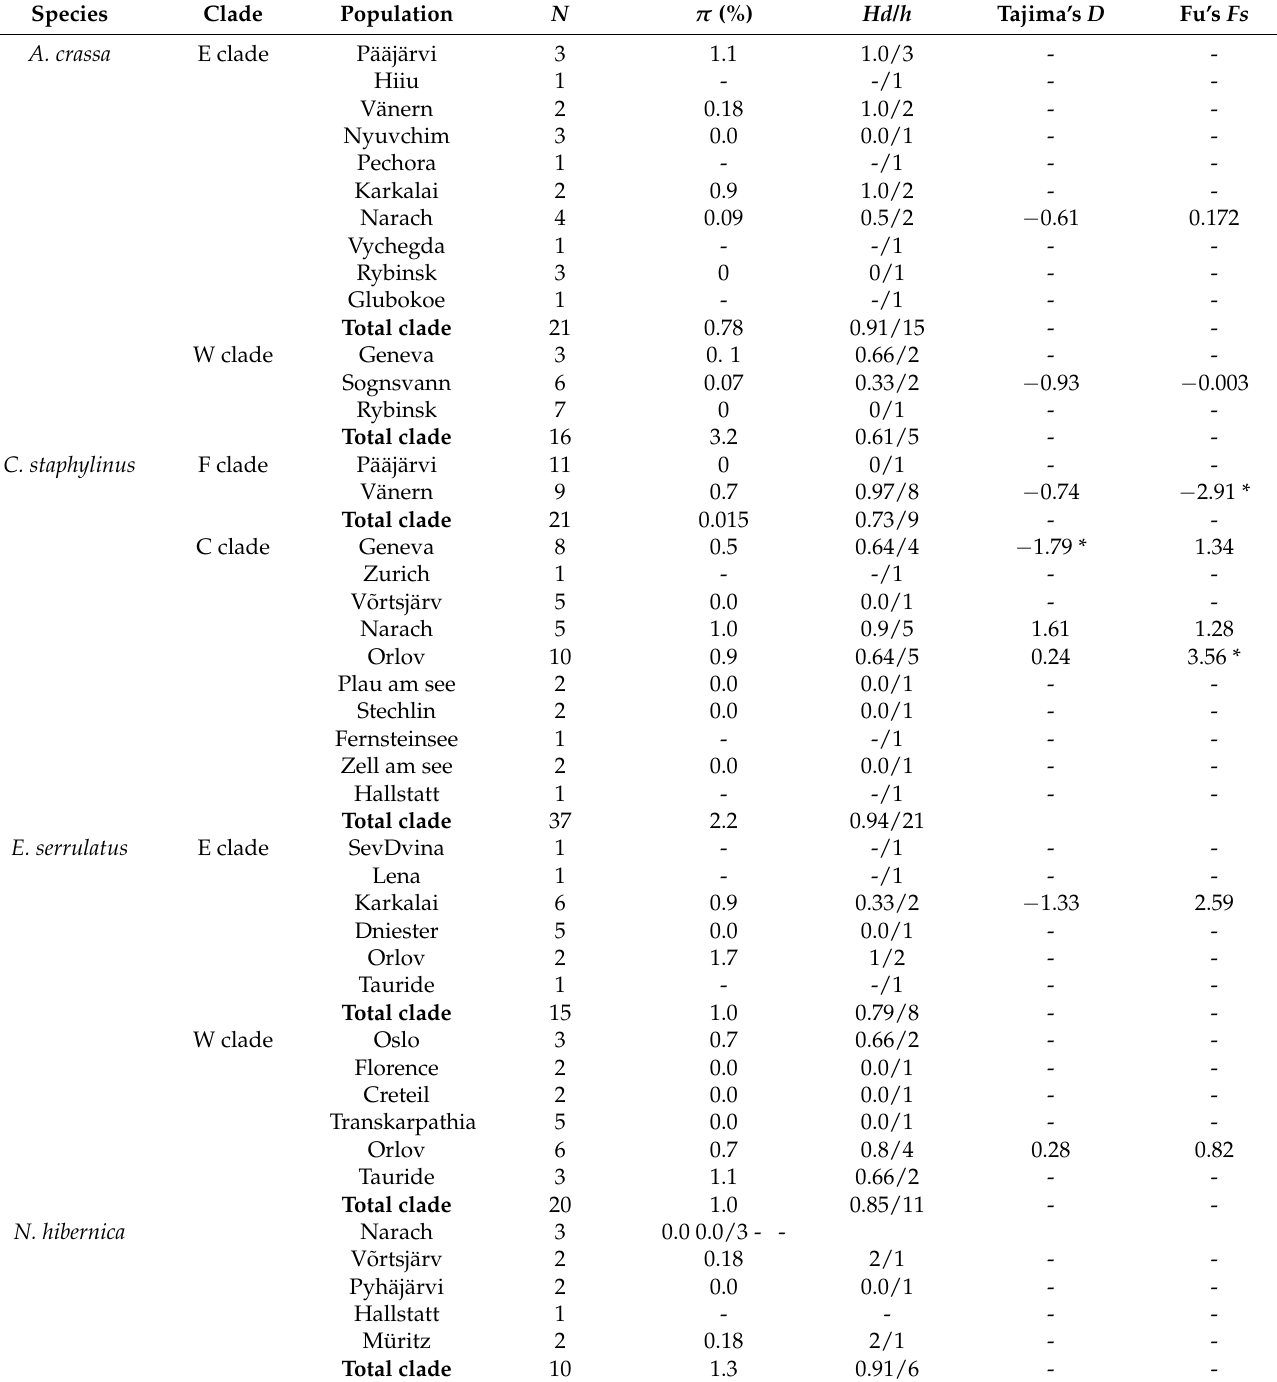
Table 3. Sample size ( N ), nucleotide diversity ( π ), haplotype diversity ( Hd ), number of haplotypes ( h ), Tajima’s D statistic and Fu’s Fs statistic among all populations of the studied species based on COI gene sequences.